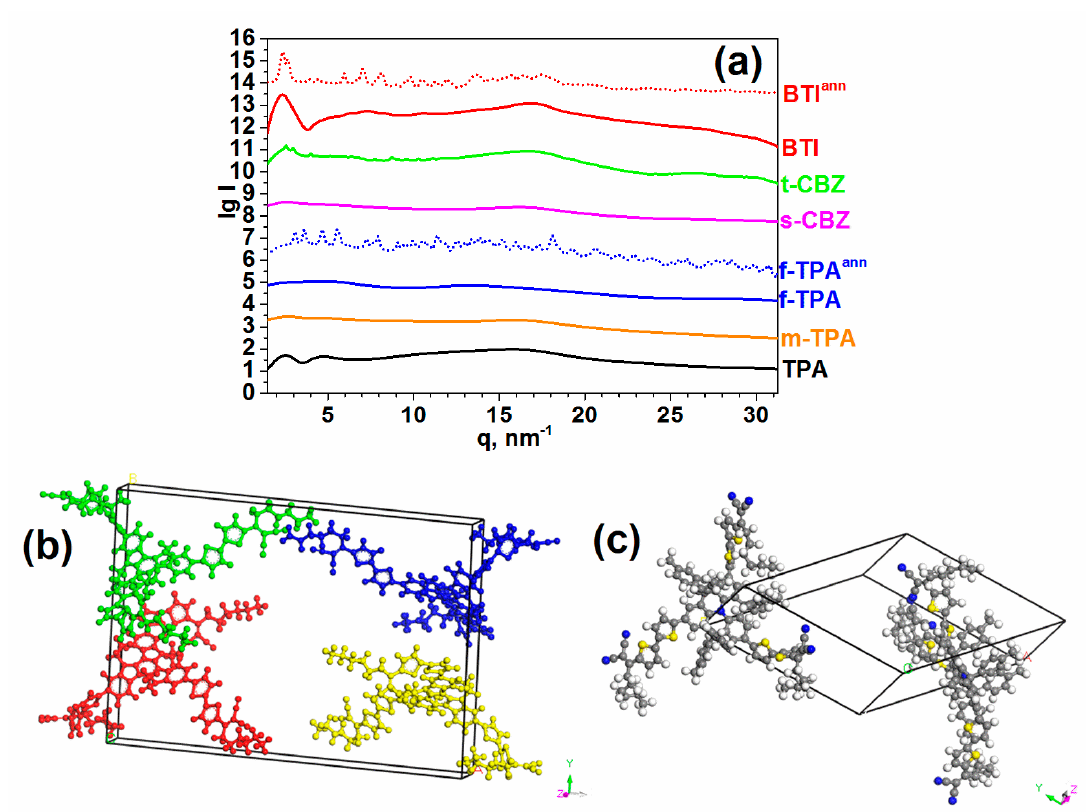
Figure 5. ( a ) XRD patterns of as-received (solid lines) and annealed (dotted lines) samples of the studied compounds. For the sake of clarity experimental curves are shifted along the intensity axis. Molecular modelling of crystal cell packing solutions for BTI ( b ) and f-TPA ( c ).